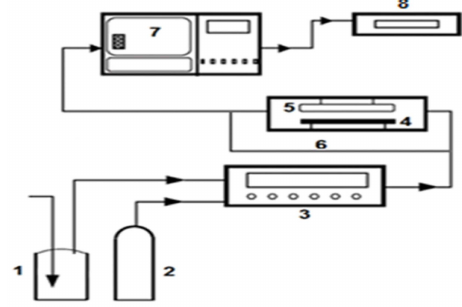
Figure 7. Schematic flow diagram of photocatalytic setup. (1) Humidifier; (2) NO gas supply; (3) test gas generator; (4) reactor; (5) UV lamp; (6) By pass; (7) NO x analyzer; (8) Data